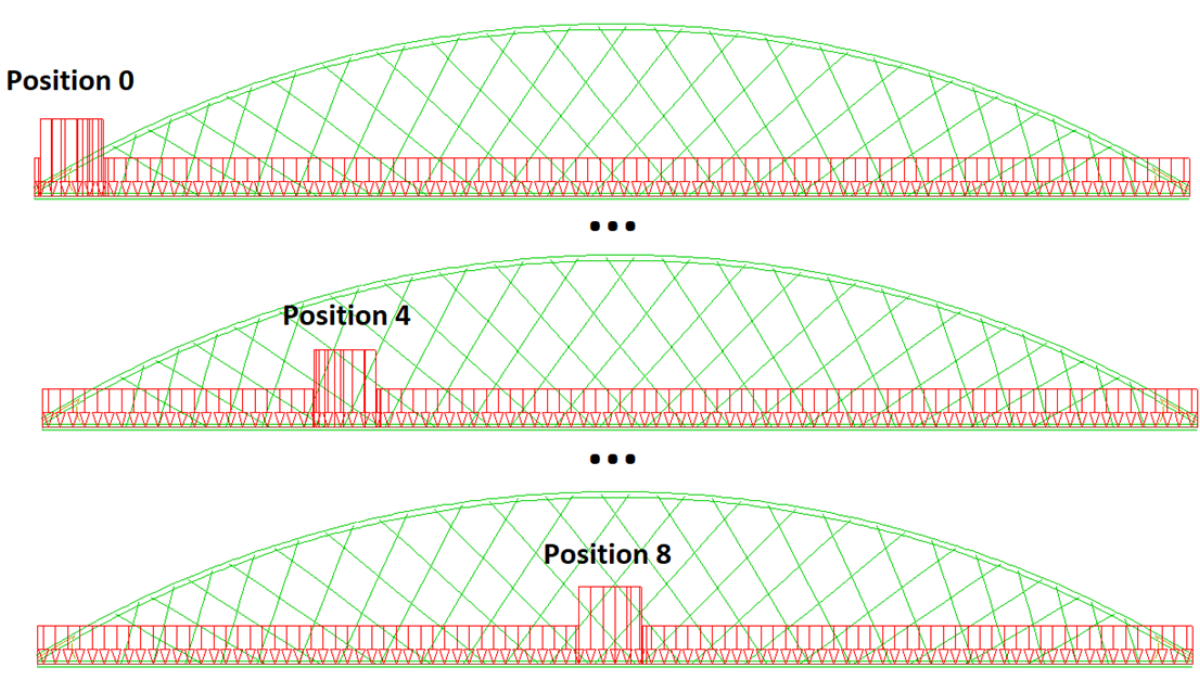
Figure 14: The LM 71 positions along the